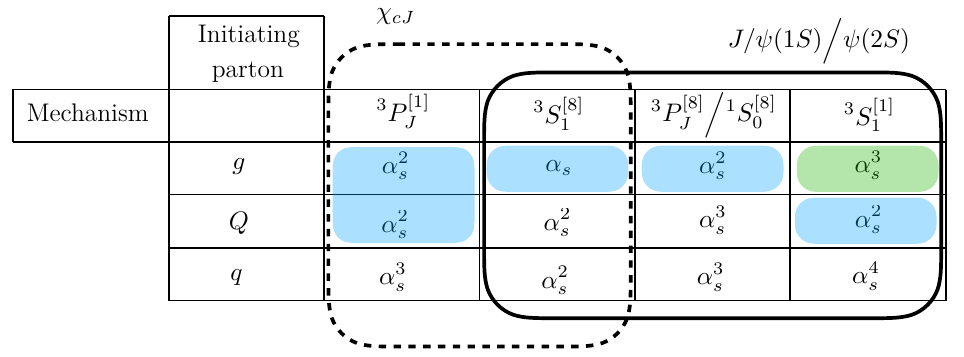
Figure 1 . Order in (cid:11) s for the leading fragmentation mechanisms for quarkonia. We include the light blue (leading per channel) and green shaded